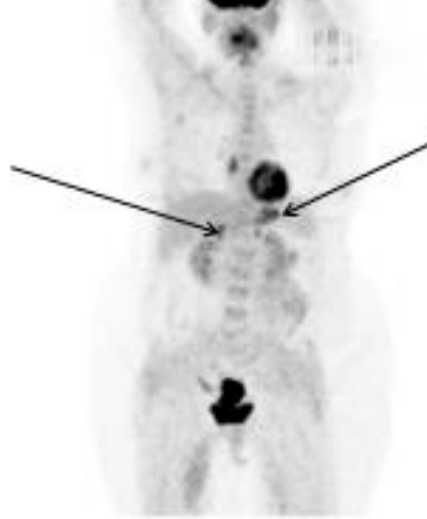
Figure 3: PET-CT scan prior to treatment initiation demonstrating hypermetabolic bilateral adrenal nodules (black arrows) with increased FDG